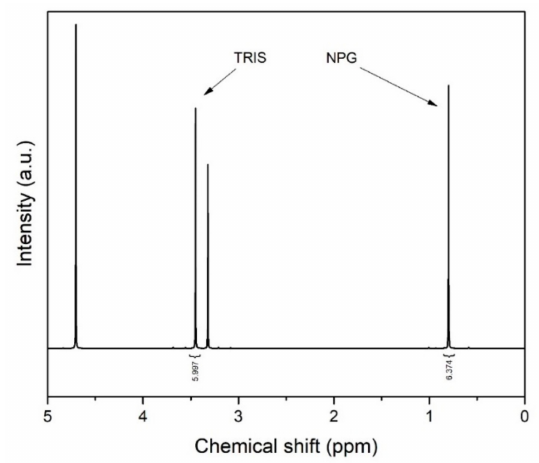
Figure A2. 1 H-NMR spectrum of the NPG-TRIS mixture with 0.485 molar fraction of